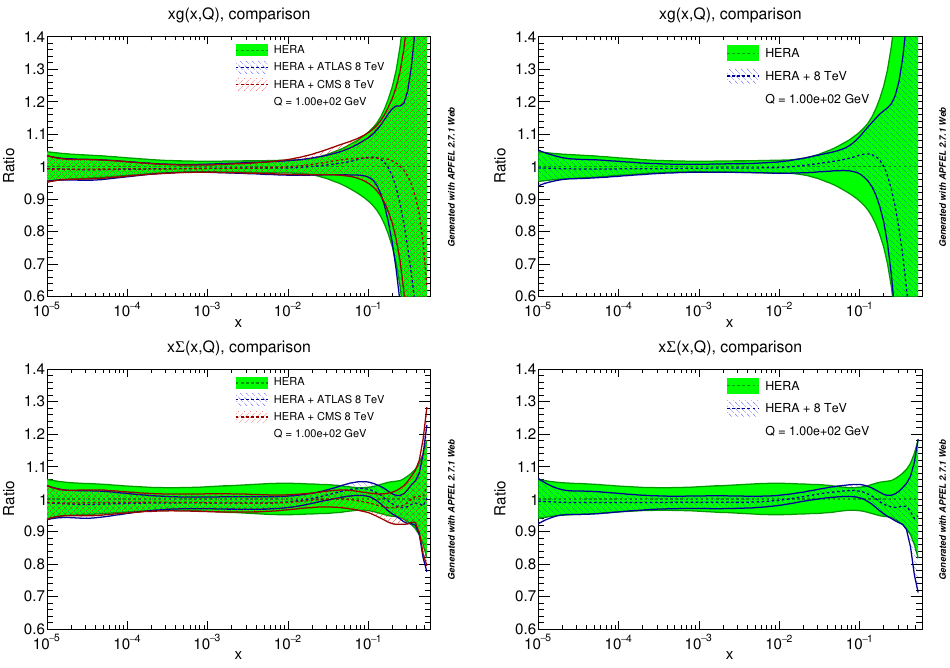
data with (cid:1) = 1% on the gluon and the singlet T